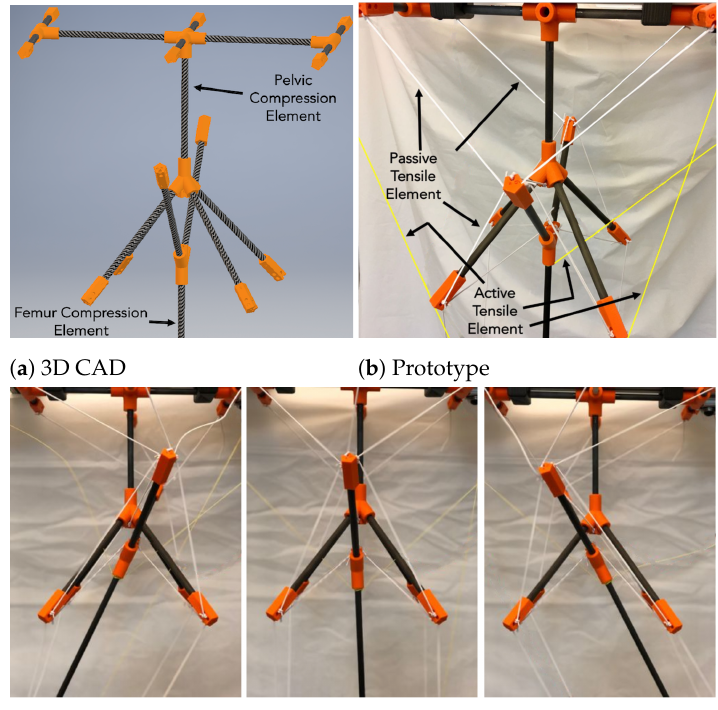
Figure 2. Tensegrity Flexural Joint: Hip.